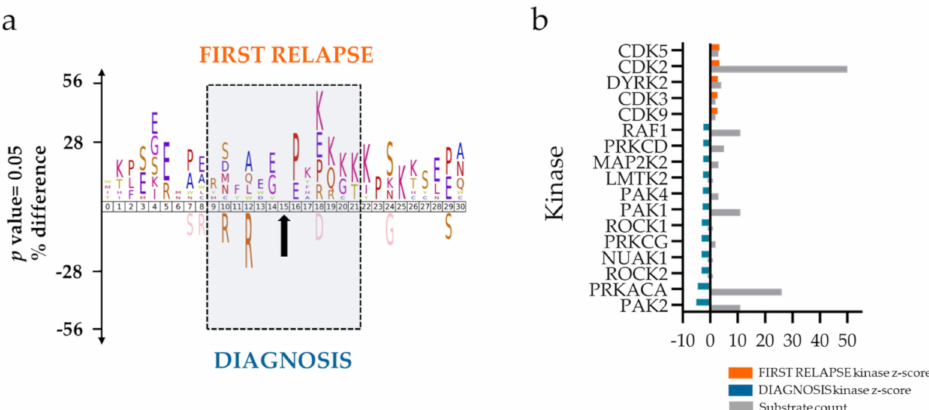
Figure 3. AML phosphoproteome in the FIRST RELAPSE group is enriched with cyclin-dependent kinases (CDKs) substrates. ( a ) Sequence motif analysis of the ± 31 amino acids flanking the di ff erentially regulated phosphorylation sites (indicated with a black arrow) for the FIRST RELAPSE and DIAGNOSIS groups. ( b ) Kinase-substrate enrichment analysis (KSEA) of di ff erentially regulated and unregulated phosphorylation sites. The kinase z -score (X axis) is the normalized score for each kinase (Y axis), weighted by the number of identified